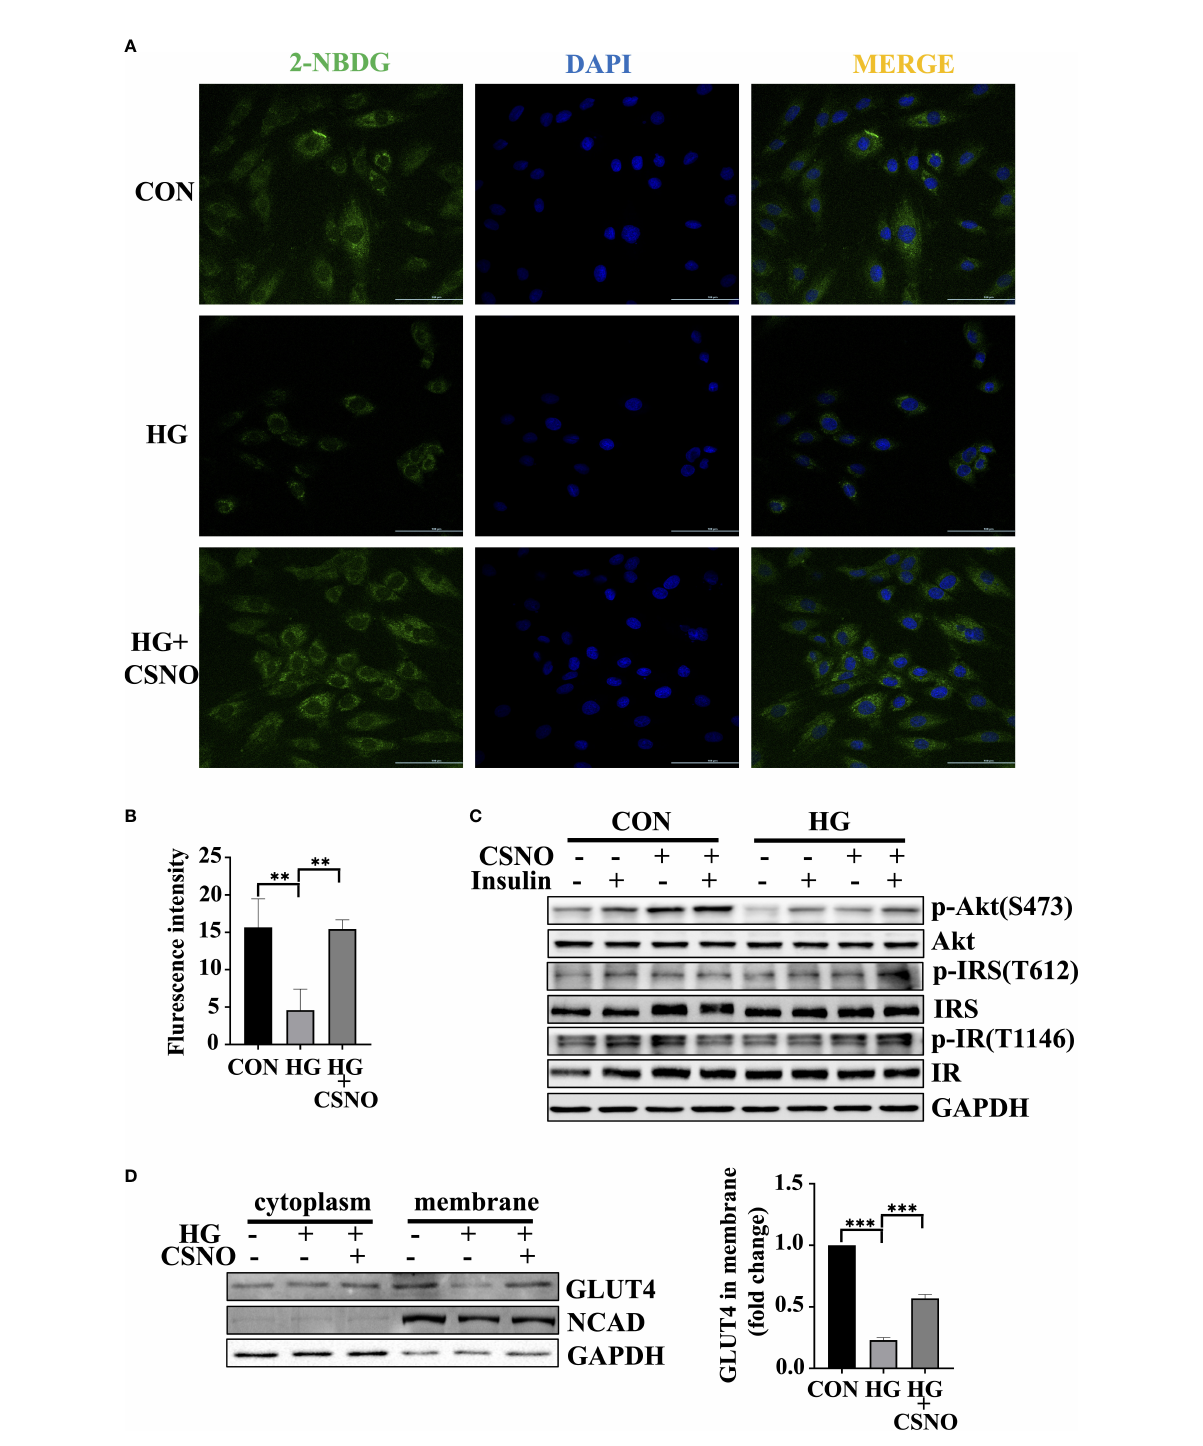
FIGURE 5 CSNO alleviated insulin resistance. (A) Glucose uptake was detected by fl uorescence analysis of 2-NBDG uptake by cells. Scale bar=100 m m. (B) The statistical graph of fl uorescence intensity which was analyzed with imageJ software. Scale bar=100 m m. (C) The expression level and phosphorylation level of Akt, IRS and IR were analyzed by Western blot. (D) After the cytoplasm and cell membrane were separated, the expression of GLUT4 on membrane protein was detected. It was normalized to N-cadherin. ** represents p < 0.01; ***represents p <